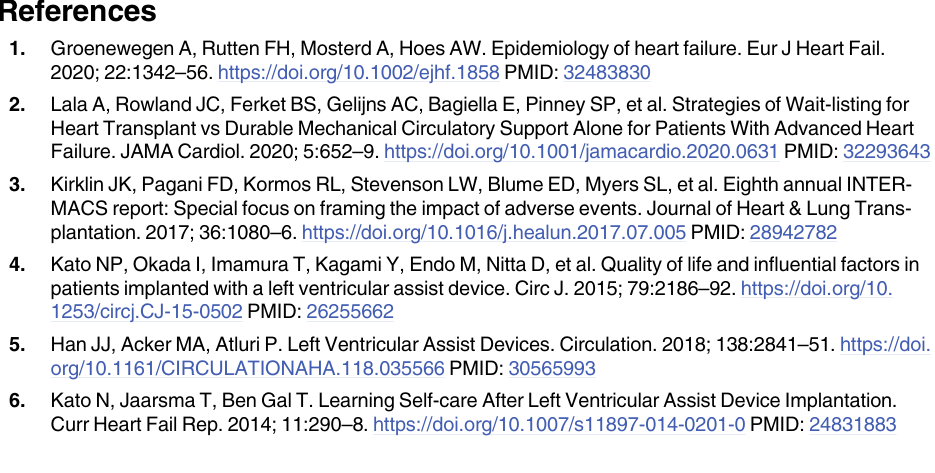
S1 Fig. How to standardise the total score on the 20-item LVAD self-care behaviour scale. (PDF) S2 Fig. The left ventricular assist device self-care behaviour